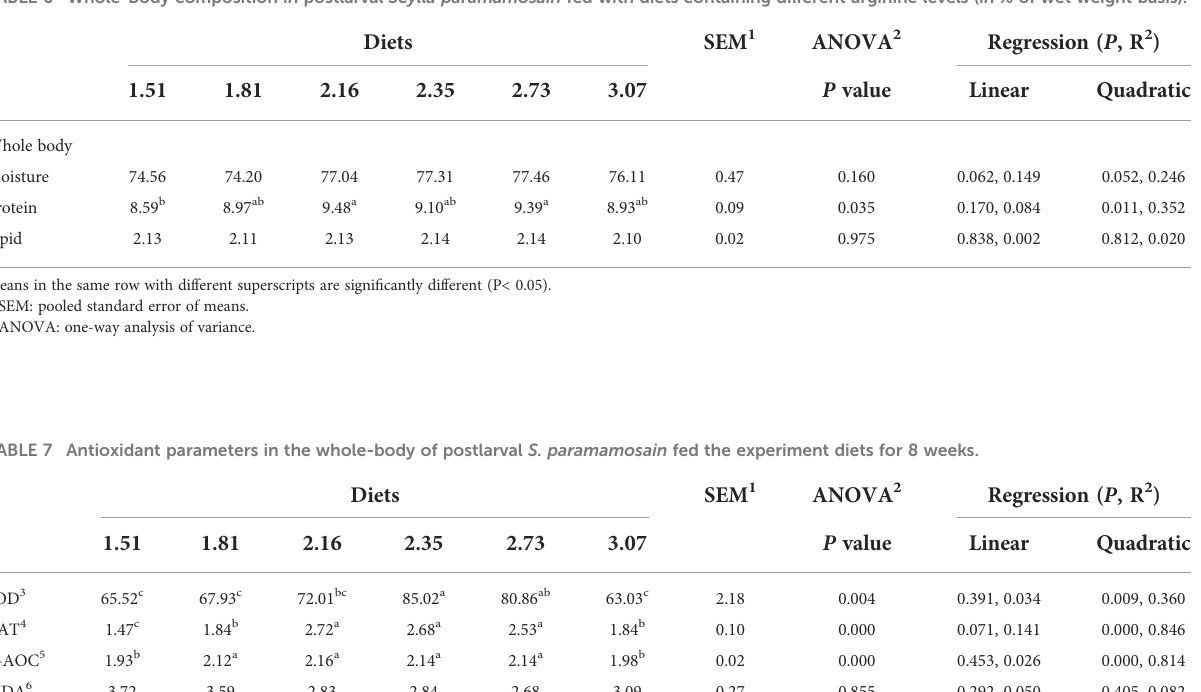
Means in the same row with different superscripts are signi fi cantly different (P < 0.05). 1 SEM: pooled standard error of means.